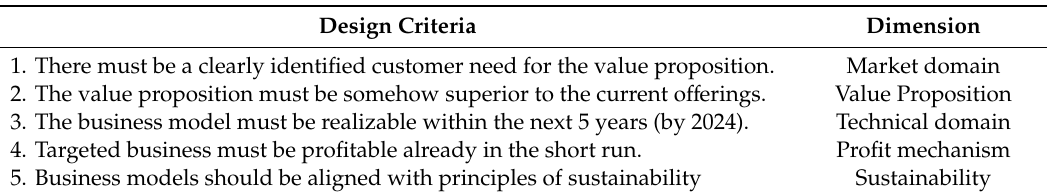
Table 6. Design criteria defined and the corresponding business model dimensions.